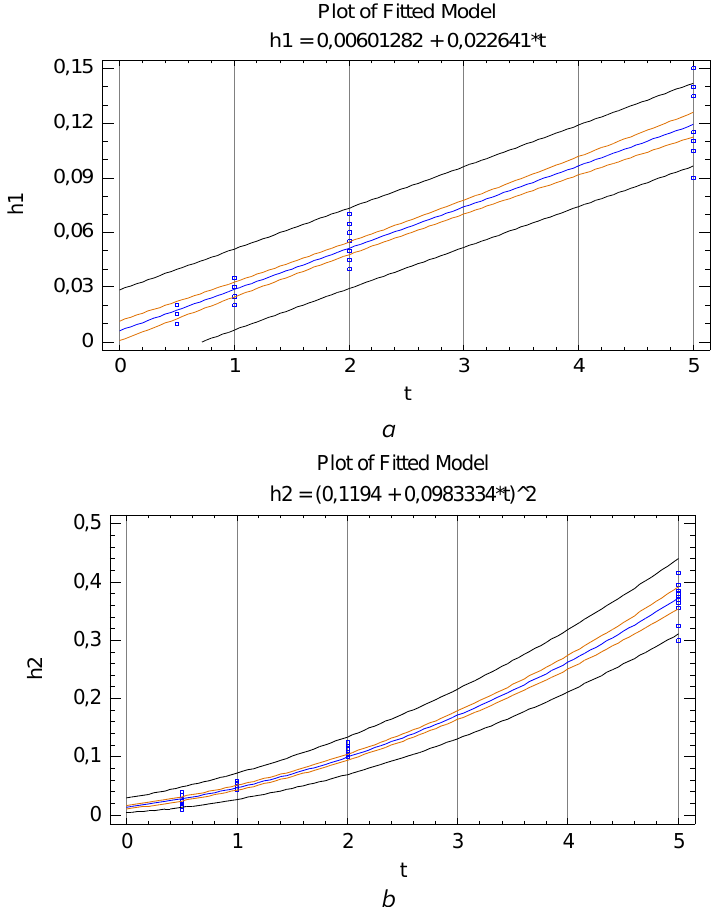
Fig. 9. The comparative diagrams wear of coating TіN ( а ) and combined coating nitrided + TiN ( b